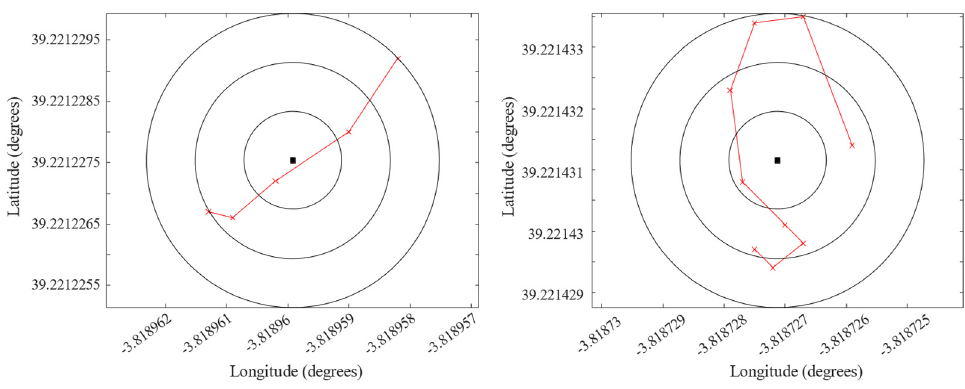
Figure 17. Error position analysis for two random waypoints.